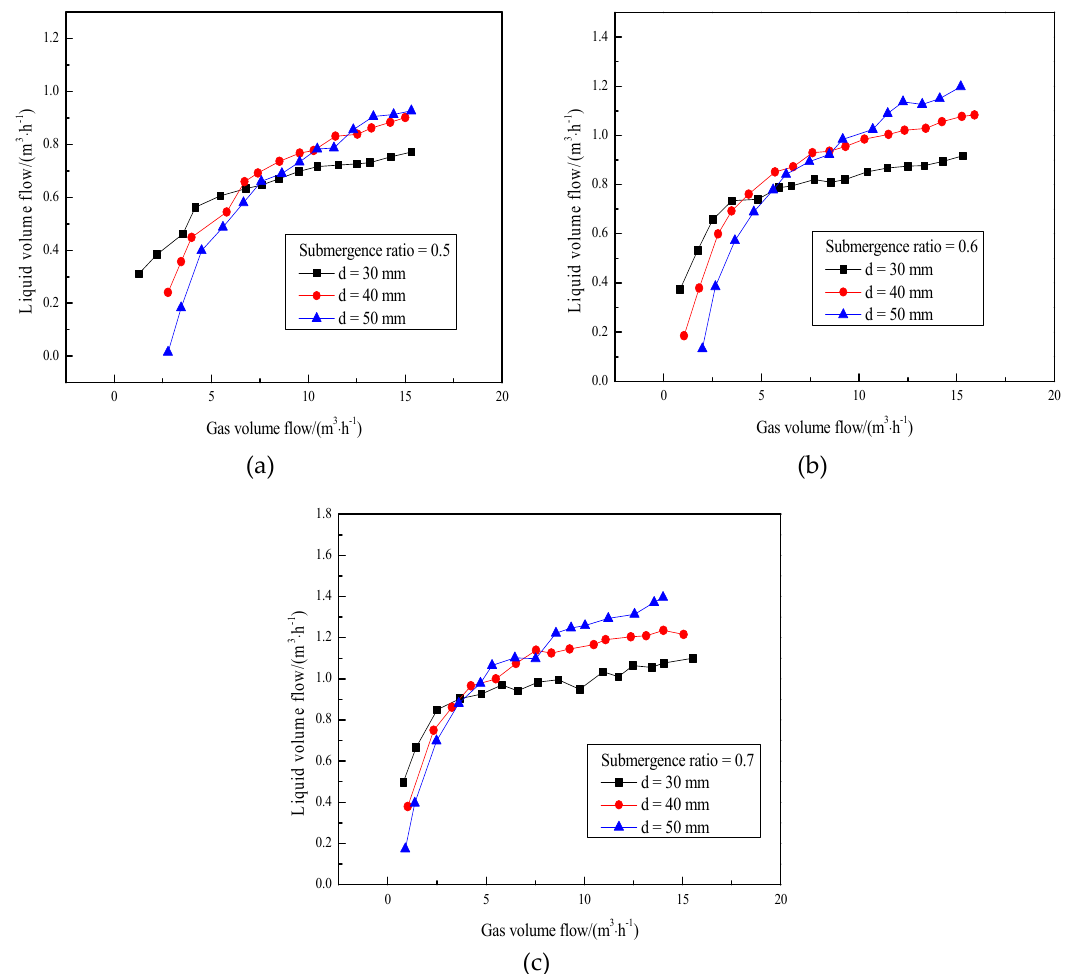
Figure 8. Changes of liquid flow with gas flow rate under different pipe diameters. ( a ) Submergence ratio of 0.5; ( b ) submergence ratio of 0.6; ( c ) submergence ratio of 0.7.